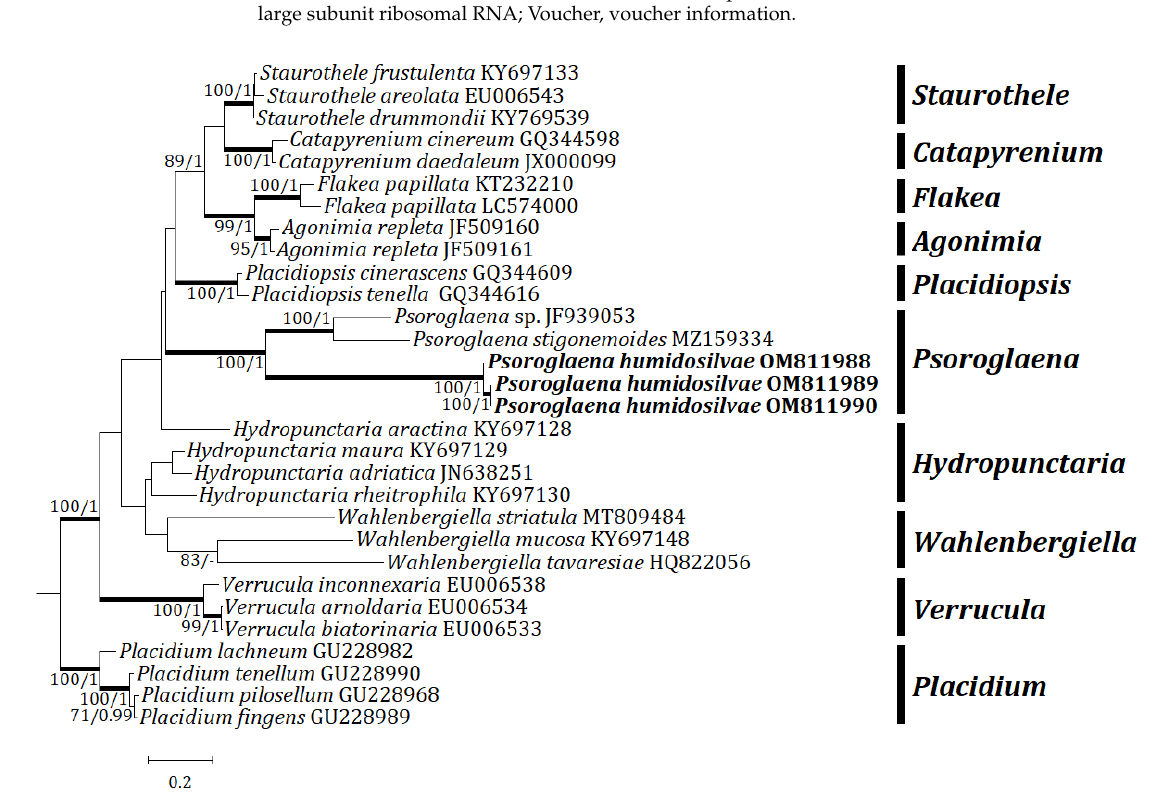
Figure 2. Phylogenetic relationships among available species in the genus Psoroglaena based on a maximum likelihood analysis of the dataset of ITS sequences. The tree was rooted with the sequences of the genus Placidium based on Muggia et al. [9]. Maximum likelihood bootstrap values ≥ 70% and posterior probabilities ≥ 95% are shown above internal branches. Branches with bootstrap values ≥ 90% are shown as fatty lines. The new species, P. humidosilvae , is presented in bold as their DNA sequences were produced from this study. All species names are followed by the GenBank accession numbers.